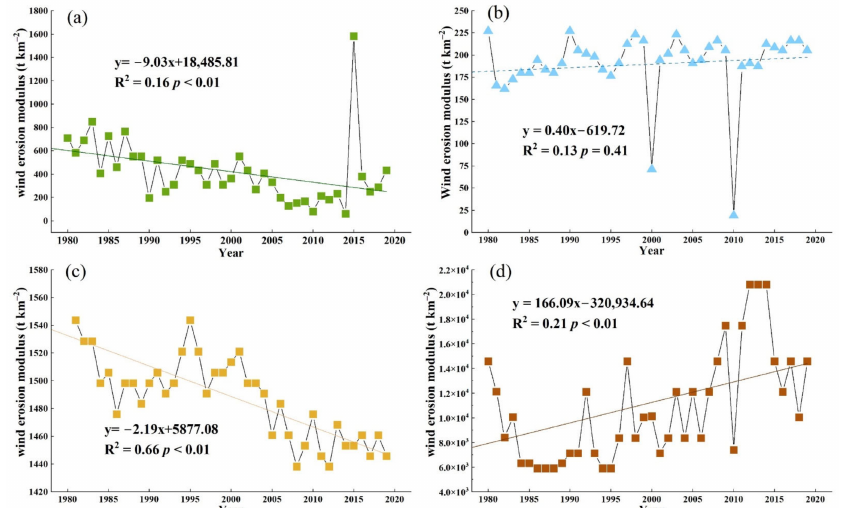
Figure 5. Dynamic wind erosion modulus in ( a ) Northeast China, ( b ) North Central China, ( c ) the Loess Plateau, ( d ) and Northwest China from 1981 to